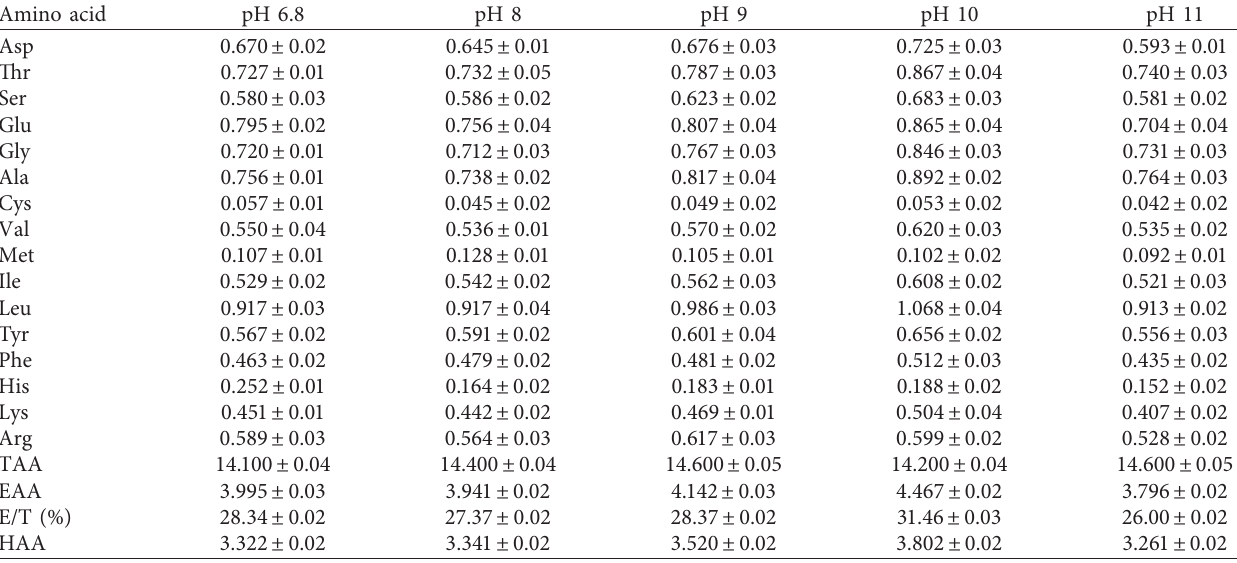
Table 2: Amino acid composition of oil body interface protein under different pH